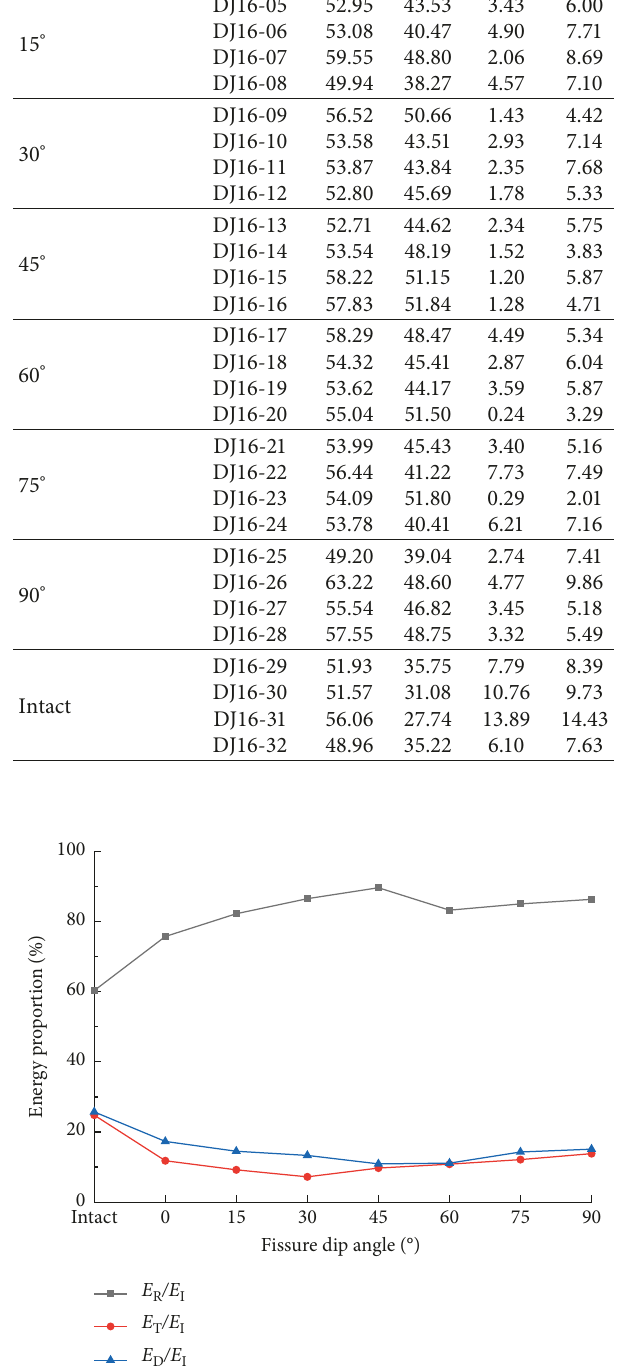
Figure 10: Relationship between the energy proportion and fissure